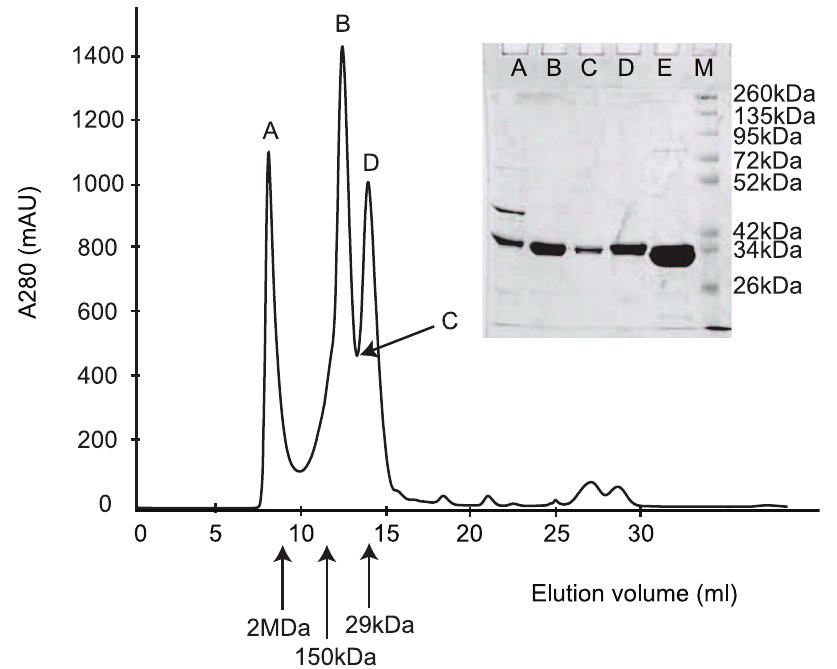
Figure 6. Size exclusion chromatography of GFP-perlucin variants. An elution profile of a typical GFP-perlucin extract was obtained by size exclusion chromatography and analyzed by SDS-PAGE. Soluble protein complexes of the 395aa and 410aa variants of GFP-perlucin (45–46.8 kDa, see Table 1 and Figure 4D,E, compare also Figure 5B, lane 1) and of the truncated variants elute first (peak A) at a volume comparable to 2,000 kDa standard. The truncated variants (29.8 kDa and 30.3 kDa, see Figure 4B,C) elute separately (B–D) at elution volumes comparable to the 150 kDa standard (peak B) and a second peak fraction comparable to the 29 kDa standard (peak D). Note that these two fractions are clearly separated (C). For control (E), soluble GFP (28.9 kDa, Figure 4A) migrated slightly faster on the SDS-polyacrylamide gel than the truncated variants (B–D) of the GFP- perlucin fusion protein. (M) Molecular weight marker. Arrows indicate the size standards: Dextran (V e =8.9 ml, 2,000 kDa); carbonic anhydrase (V e =14.12 ml, 29 kDa), ß-amylase (V e =11.02 ml, 150 kDa).